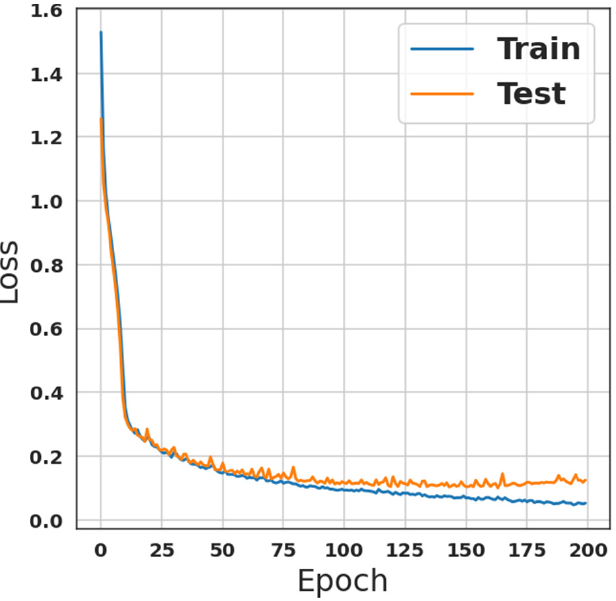
Figure 4. ANN-model loss during training-phase. Table 5. Comparison results of LR, first model (custom CNN + LSTM), and ANN